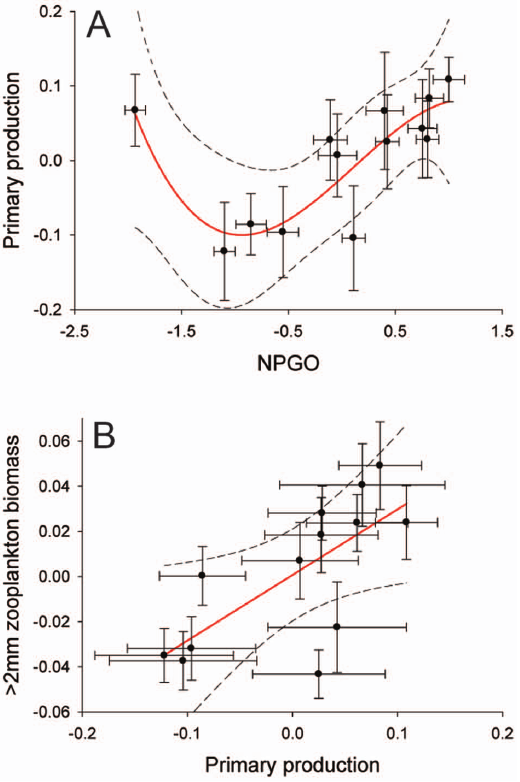
Figure 6. Significant relationships among environmental variables that correlated significantly with box jellyfish abundance at Waikiki Beach. A) Non-linear relationship between primary production and NPGO detected by using Generalized Additive Models ( GAM ). B) Linear relationship between zooplankton biomass and primary production detected by using General Regression Models ( GRM ). Biogeochemical variables were obtained at Station ALOHA, from the Hawaiian Oceanographic Time-series program (HOT) at http:// hahana.soest.hawaii.edu/hot/. Solid red line represents the model fit, and dashed lines represent 99% confidence levels. Bars represent standard errors.